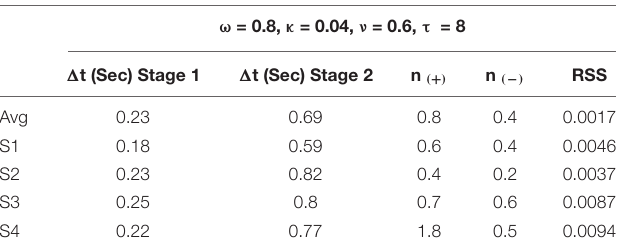
TABLE 1 | Parameters used to fit the model to the responses of the four subjects who performed the experiment and the average of